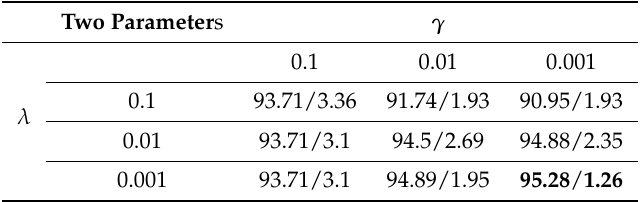
Table 2. Average recognition rates and standard deviations of LRCS with different parameter settings on the Traffic dataset